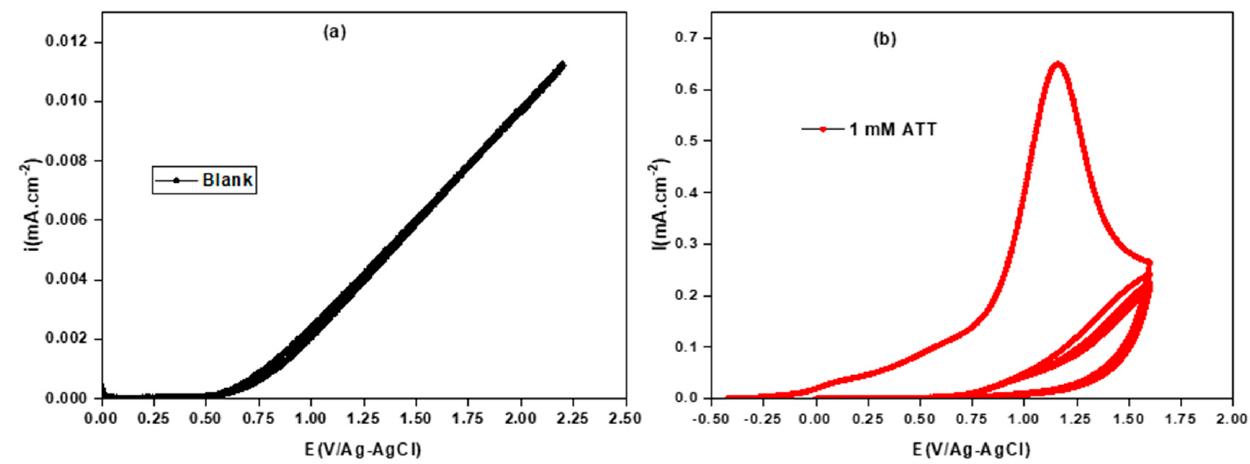
Figure 1. Voltammograms in the absence ( a ) and in the presence of monomer ( b ) on the electrode 60Cu-40Zn ([ATT] = 1 mM), dE/dt = 10 mV · s − 1 ). The addition of monomer in the electrolytic medium indicates the appearance of a peak oxidation in the anodic domain (Figure 1b). This peak corresponds to the oxidation of ATT because it is absent in the control [12] (Figure 1a). However, no peak was detected during the cathodic scanning (return), showing that the species formed by oxidation of 3-amino-1,2,4-triazole-5-thiol are unstable free radicals. These radicals and their mesomer forms are coupled together to form a polymer deposit on the electrode surface. The anodic current peak appears at a potential of 1.15 V in the first cycle; from the second cycle, no peak is observed. The absence of a current peak during another potential sweep (go) can be explained by the formation of a homogeneous and compact film. At the end of the oxidation of the monomer, the current density stabilizes at a value of 0.3 mA · cm − 2 , which shows that the synthesized polymer film is